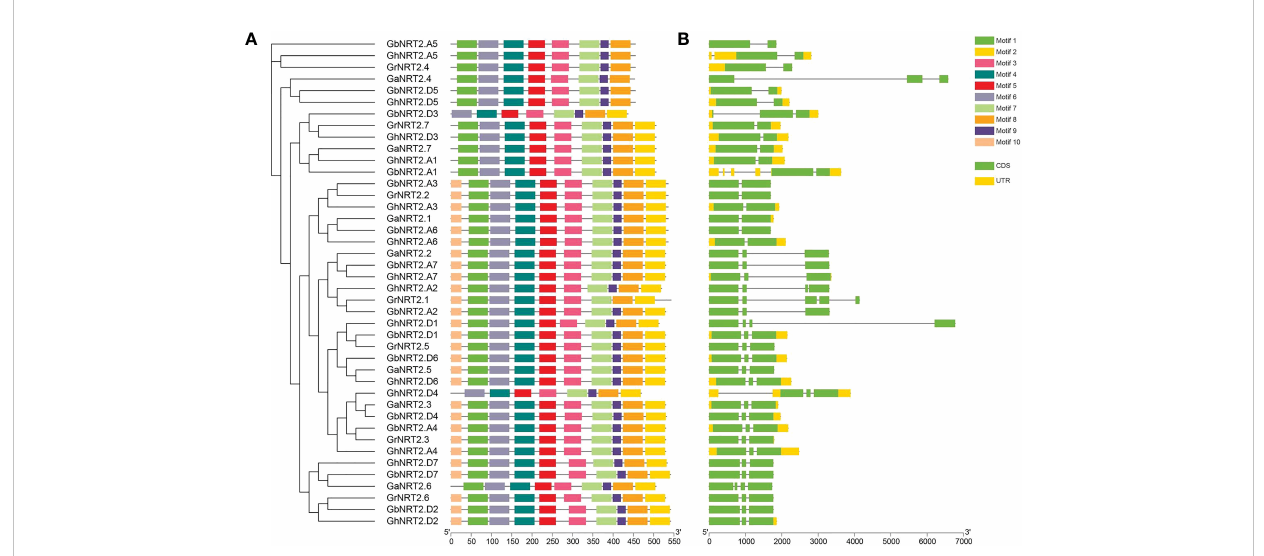
FIGURE 1 Phylogenetic tree and sequence structures of the candidate NRT2s in four cotton species ( G.arboreum, G.raimondii, G.barbadense , and G.hirsutum ). (A) Neighbor-joining (NJ) phylogenetic tree of NRT2s in four cotton species. Different colors represent different motifs. (B) Gene structures of NRT2s in cotton. CDS are shown as green boxes, UTR are shown as yellow boxes, and the lines between the colored boxes correspond to the introns. Numbers below represent the